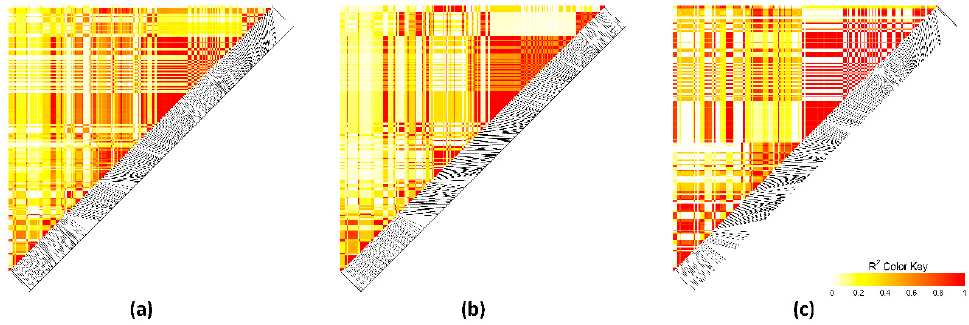
Figure 4. Linkage disequilibrium plot at 34–37.9 Mb on chromosome 1. Colors from white to red indicate r 2 value. ( a ) All lines. ( b ) High-intramuscular fat (IMF) line. ( c ) Low-IMF line. Animals 2020 , 10 , x